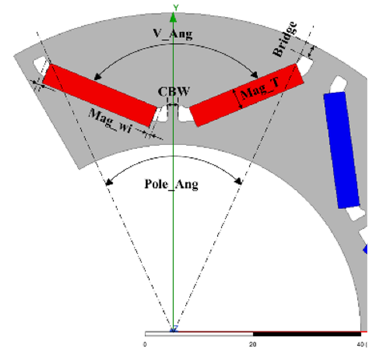
Figure 1. Illustration of the preliminary design of PMSM. Table 2. Magnetic design parameters of PSMS.